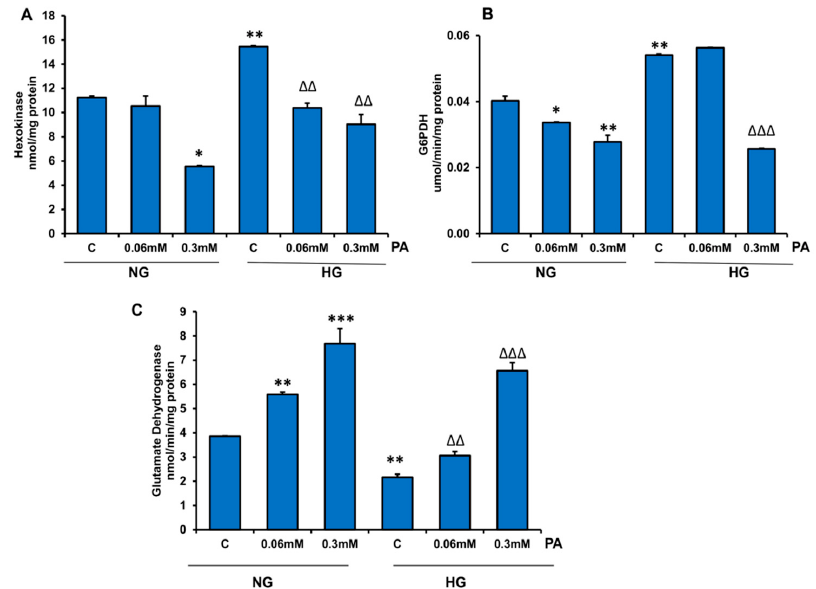
Figure 10. Effect of high glucose/high palmitic acid (HG/HPA) on cytosolic energy metabolizing enzymes. HepG2 cells were treated with high glucose and high palmitic acid, and the activities of hexokinase ( A ), glucose-6-phosphate dehydrogenase (G6PDH) ( B ), and glutamate dehydrogenase (GDH) ( C ) were measured as described in the Materials and Methods section. Results are expressed as mean +/ − SEM of three experiments. Asterisks indicate significant differences (* p ≤ 0.05, ** p ≤ 0.005, *** p ≤ 0.001) relative to untreated control cells under normal glucose condition (NG-C), and triangles indicate significant differences ( ΔΔ p ≤ 0.005, ΔΔΔ p ≤ 0.001) relative to untreated control cells under high glucose condition (HG-C).